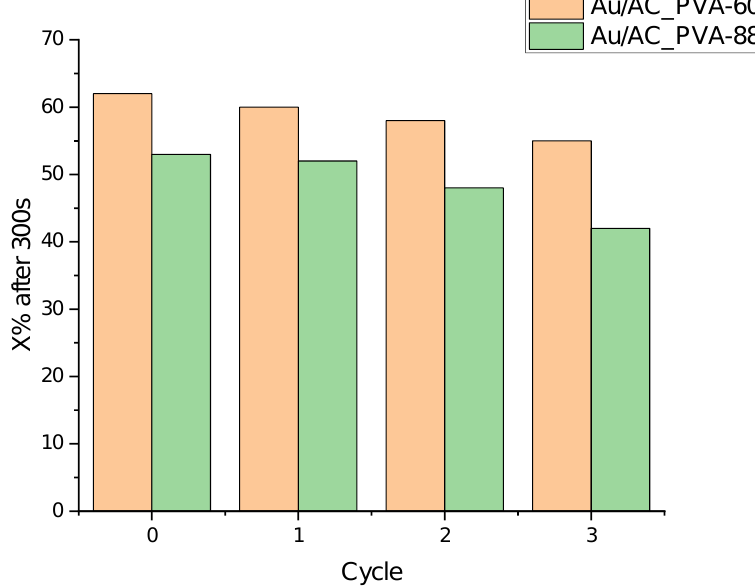
Figure 7. Reusability tests on 4-NP reduction using two catalysts prepared with either a synthesized or a commercial